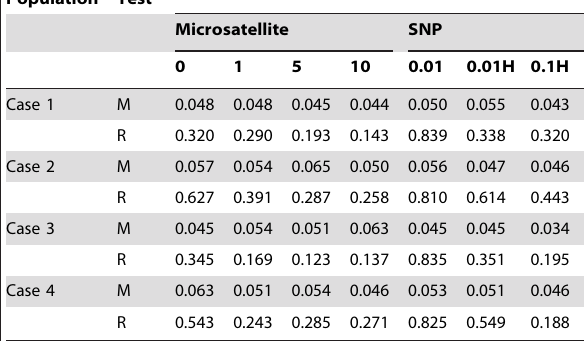
Population Test * Marker Interval (cM)